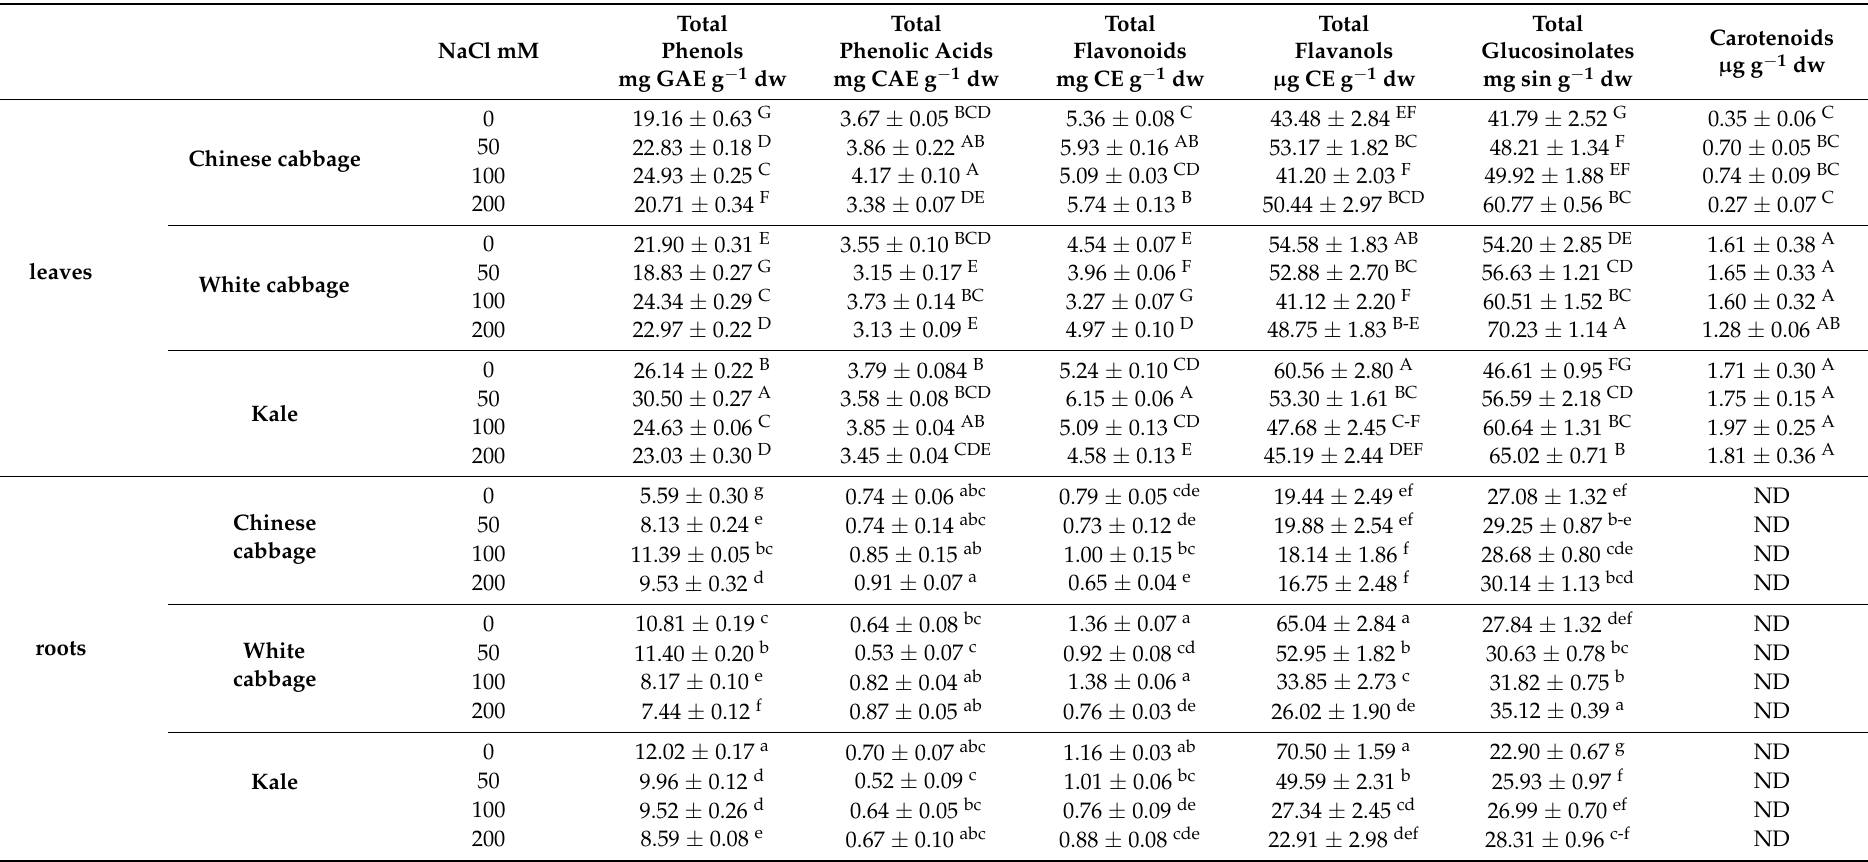
Table 2. Groups of specialized metabolites measured in Brassica leafy vegetables: Chinese cabbage, white cabbage, and kale, upon salinity treatments (0–200 mM NaCl). Data labeled with different letters differed significantly at p < 0.05 for each particular group of specialized metabolites among the three species. Statistical analysis was performed in each column, separately for leaves (capital letters) and roots (small